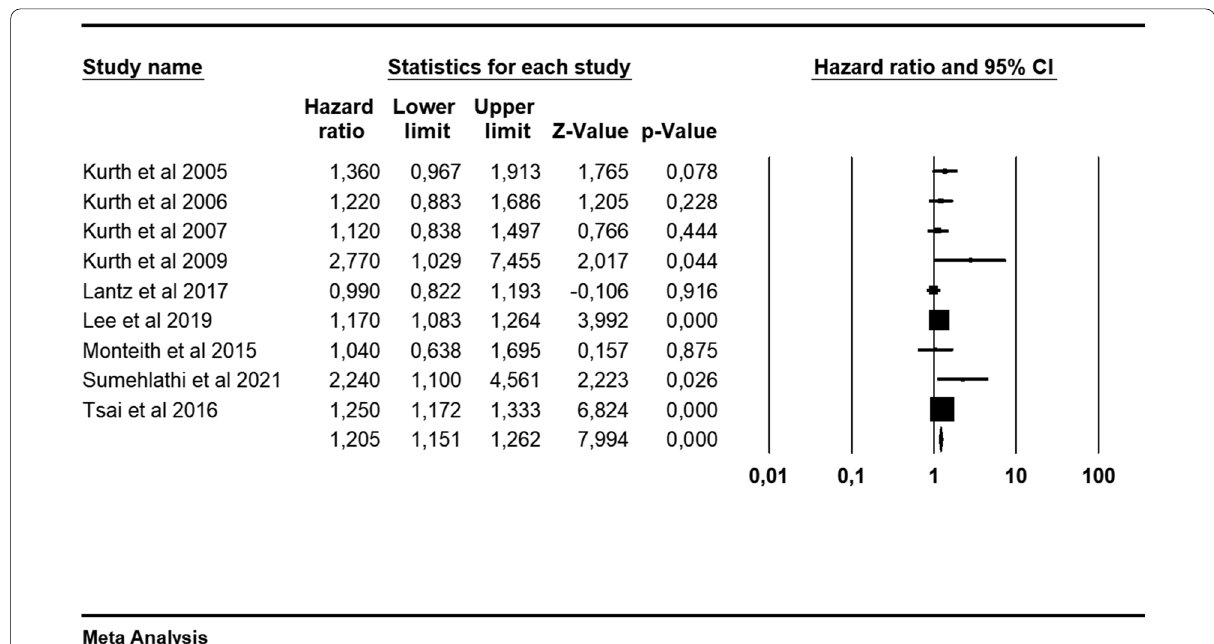
Fig. 2 Random-effect models meta-analysis for migraine and ischemic